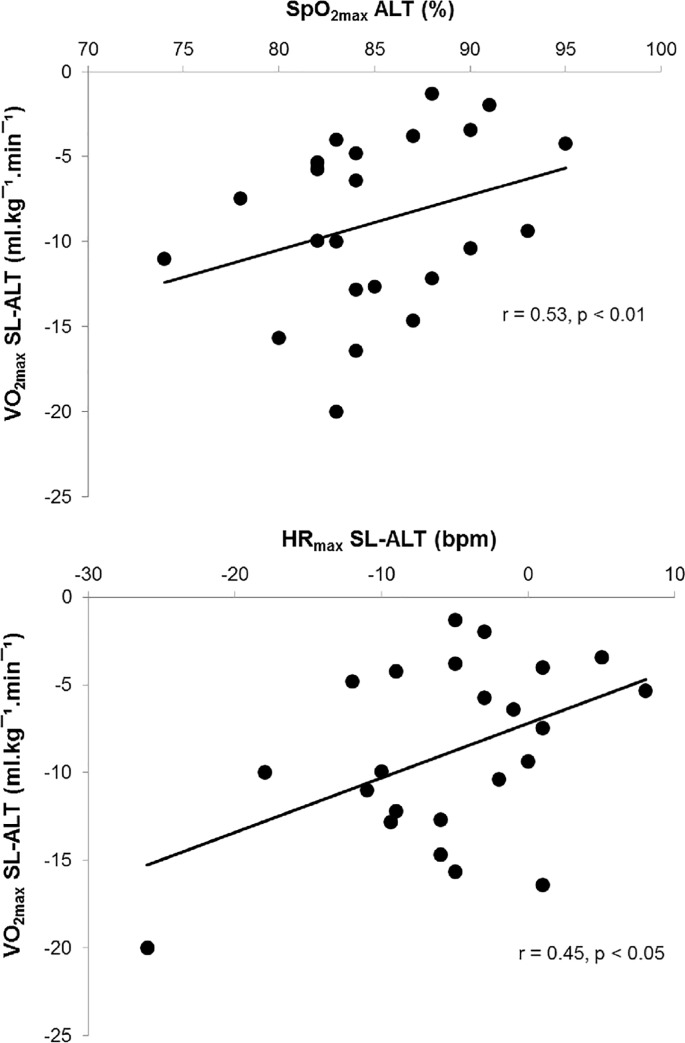
Correlations between decrease in VO2max (VO2max SL-ALT, difference between sea level and altitude values) with SpO2 values at the end of exercise at altitude (SpO2max ALT) and with decrease in HRmax (HRmax SL-ALT, difference between sea level and altitude values).All participants were considered, n = 23.